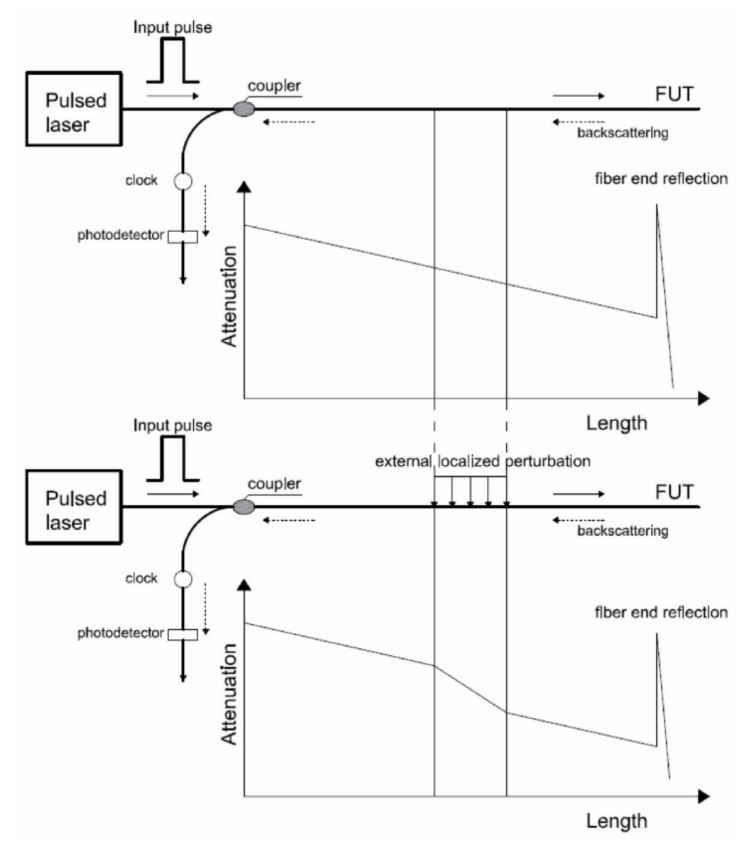
Figure 7. OTDR method-Rayleigh backscattering